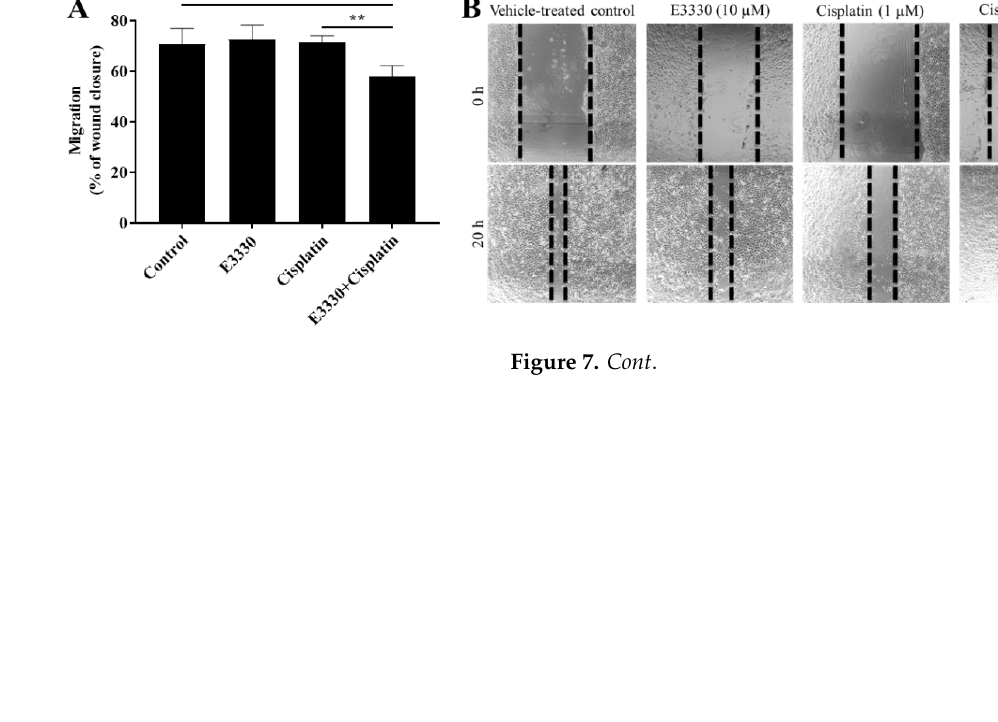
Figure 7. E3330 effect on collective and chemotactic migration of H1975 cells exposed to cisplatin. Collective cell migration was evaluated by the wound-healing assay ( A ) and chemotaxis was measured using a transwell assay ( C ). Representative microscopy images of the wound-healing assay (40×, B ) and the chemotaxis assay (migrating cells stained with crystal violet – 100×, D ). Scale bars = 200 μm. Values for the wound-healing assay represent mean ± SD ( n = 3) and are expressed as percentage of wound closure, calculated relative to the initial width; * p < 0.05 and ** p < 0.01 (Student’s t -test). Values for the chemotaxis assay represent mean ± SD ( n = 3) and are expressed as percentages relative to vehicle-treated control cells; * p < 0.05 (Student’s t -test). 3.6. The Combination of E3330 and Cisplatin Decreases Invasion of H1975 Cells For the progression of cancer and metastases formation, cancerous cells located in the primary tumor need to be able to invade through the extracellular matrix and consequently migrate throughout blood circulation and/or lymphatic vessels and attach to a distant site in response to a stimulus. Considering these processes, the effect of E3330 on the invasion of cisplatin-treated H1975 cells was evaluated by the transwell chemoinvasion assay (Figure 8A). Since the proteolytic degradation of basement membranes is essential for invasion processes and subsequent metastasis formation, this assay was performed under the same conditions as the chemotaxis migration assay but with the incorporation of an ECM gel. Similar to the results from the migration assays, both E3330 and cisplatin alone did not induce a significant effect in terms of cell invasiveness. However, when both compounds were combined, there was a statistically significant decrease of approximately 17% ( p < 0.01) in chemoinvasion when compared to vehicle-treated control cells. This decrease was also statistically significant when comparing the combination of compounds with cisplatin-treated H1975 cells ( p < 0.05). Representative images of the chemoinvasion assay are presented in Figure 8B.